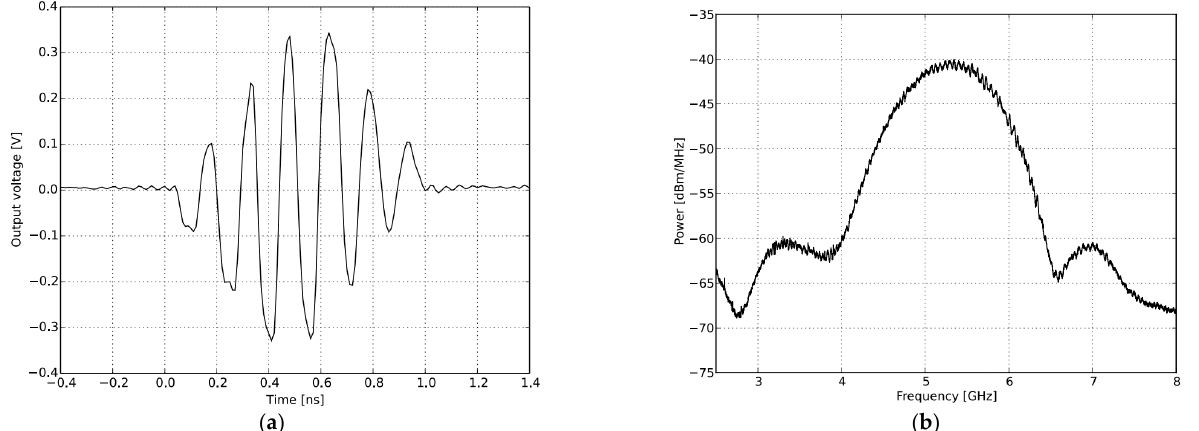
Figure 8. The Transmitted Pulse Shape and frequency spectrum of IR-UWB radar for PGSelect = 0: ( a ) transmitted signal impulse in the time domain; ( b ) transmitted signal impulse in the frequency domain.